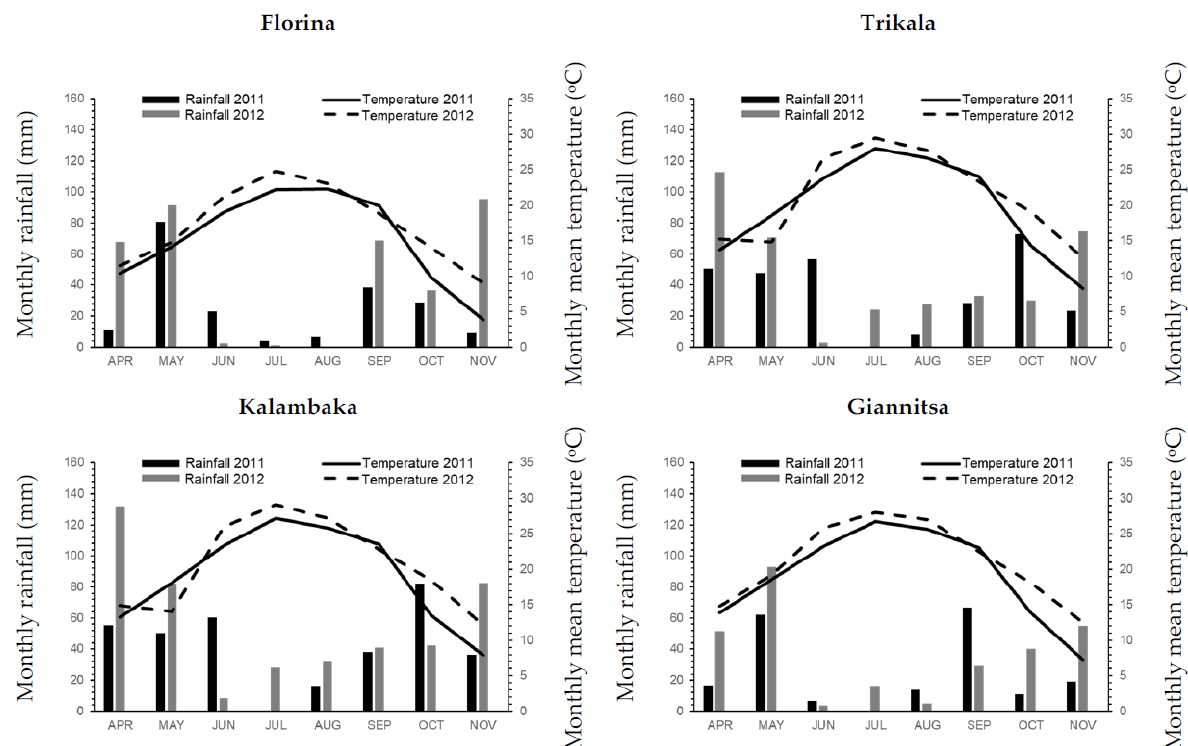
Figure 1. Basic weather data (mean monthly temperature in °C and rainfall in mm) based on daily records, through two growing seasons.